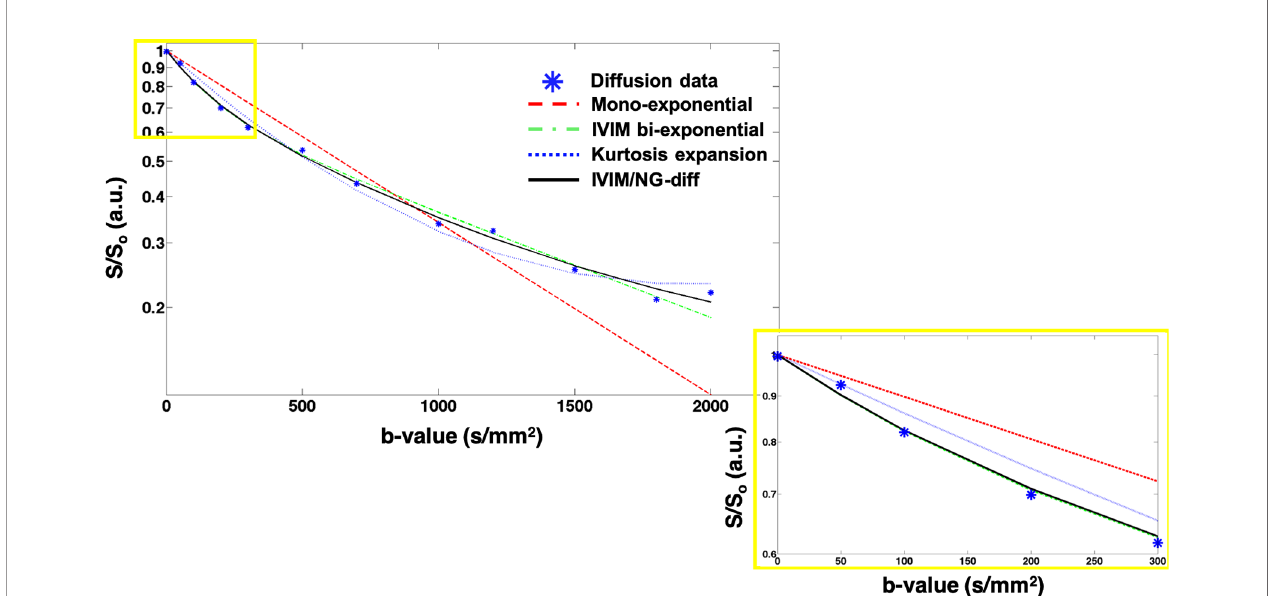
FIGURE 1 | Signal decay vs. b-value between 0 and 2000 s/mm 2 . The lines represent a fi tted curve taking into account the mono-exponential (red dashed), the IVIM bi-exponential (green dash dotted), the kurtosis expansion (blue dotted), and the combined IVIM/NG-diff (green line). The in fl uence of IVIM is apparent in the lower b-value range (0-200 s/mm 2 ) (inset), while at the higher b-values (1500-3000 s/mm 2 ), the signal deviates from the mono-exponential, exhibiting evidence of